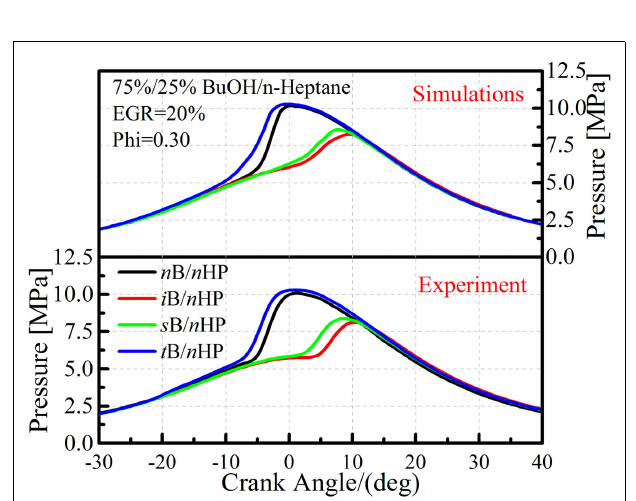
FIGURE 11 | Comparison of in-cylinder pressures between simulations and experiments for four butanol/ n -heptane mixtures .